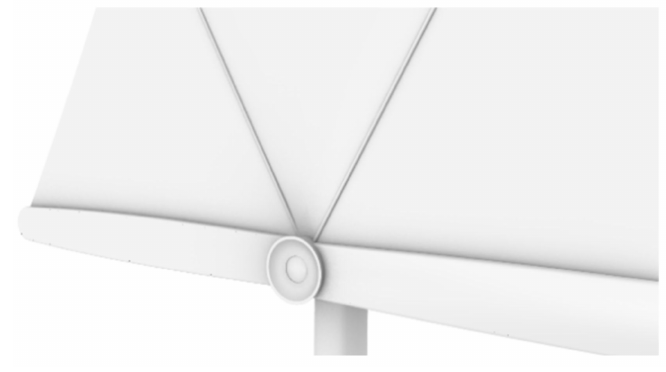
Figure 23. Unfolded shading